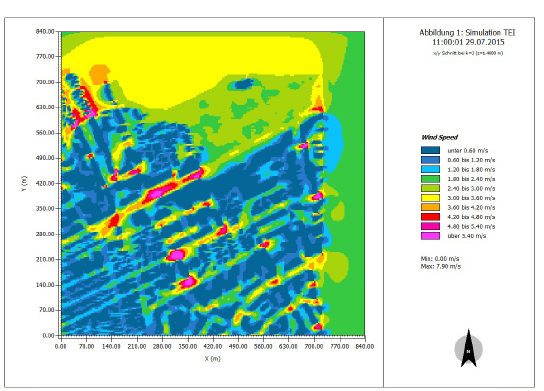
Figure 5. The 3D layout of the buildings and wind speeds around them